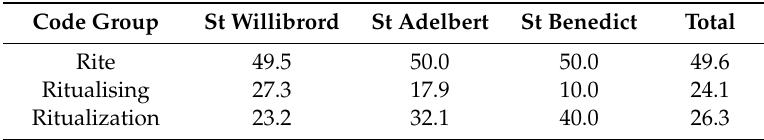
Table 4. Dimensions of prayer—monastic context. Code Group St Willibrord St Adelbert St Benedict Total Rite 49.5 50.0 Ritualising 27.3 Ritualization 23.2 32.1